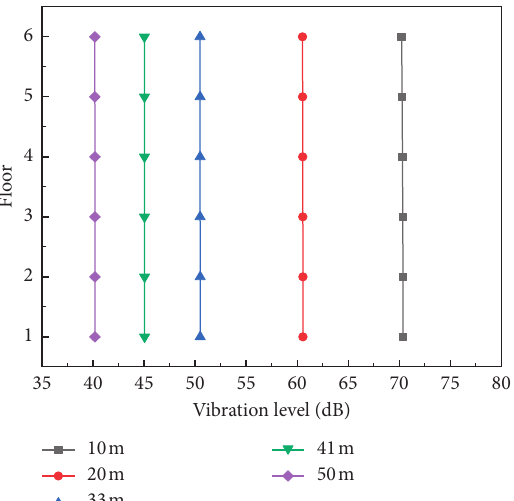
Figure 8: The vibration level of different floors with different distances from the building.